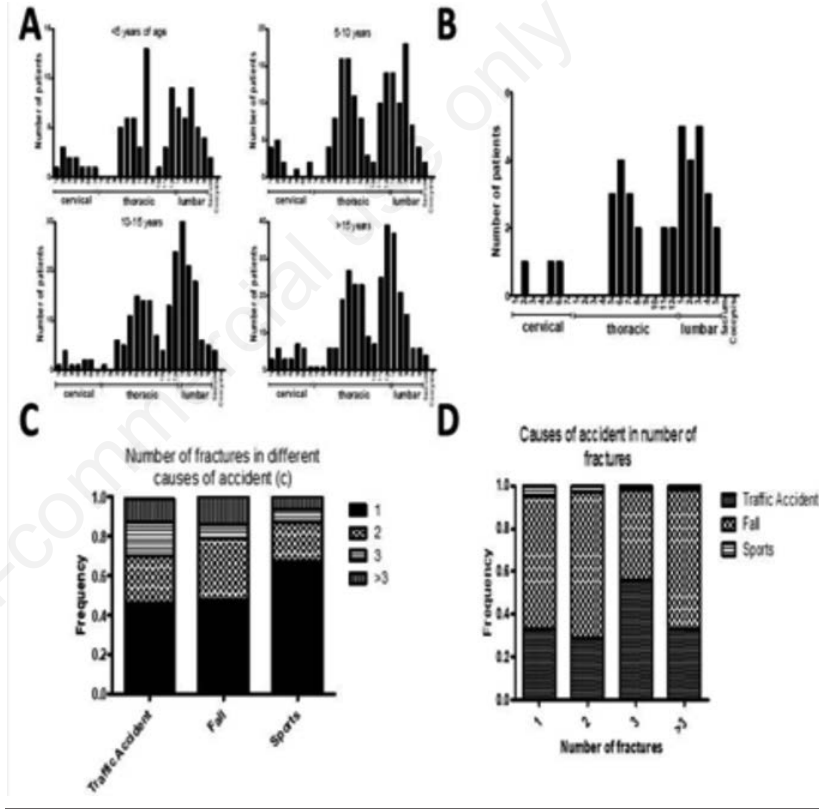
Figure 3. Localization of fractures in different ages (A). Localization of 90 fractures in children <5 years of age. A peak in T8 next to the lumbar peak can be detected in the youngest patients Between 5 and 10 years of age, the thoracolumbar region is mostly affected (161 fractures). The lumbar region is mostly affected in 209 teenage fractures between 10 and 15 years. In adolescents from 15 years on, the lumbar region remains the most affected region in 304 fractures. Thirty-eight operated fractures correlated with the location of vertebral fractures (B). Surgery was most commonly performed in the lumbar spine followed by the thoracic region. Injuries in the cervical spine rarely underwent sur- gery. Number of frac-tures in different causes of accident (C). In traffic accidents, single fractures represent less than half of all fractures, whereas single fractures represent more than 60% of all fractures in sporting accidents (Traffic accidents: 145, Falls: 260, Sports: 10). No statistically significant differences were noted among the causes of accident. Causes of accident in number of fractures (D). Single fractures are mostly caused by falls followed by traffic accidents. This distribution was also noted for double and multiple fractures (single fractures: 201, double fractures: 119, triple fractures: 45, multiple frac- tures: